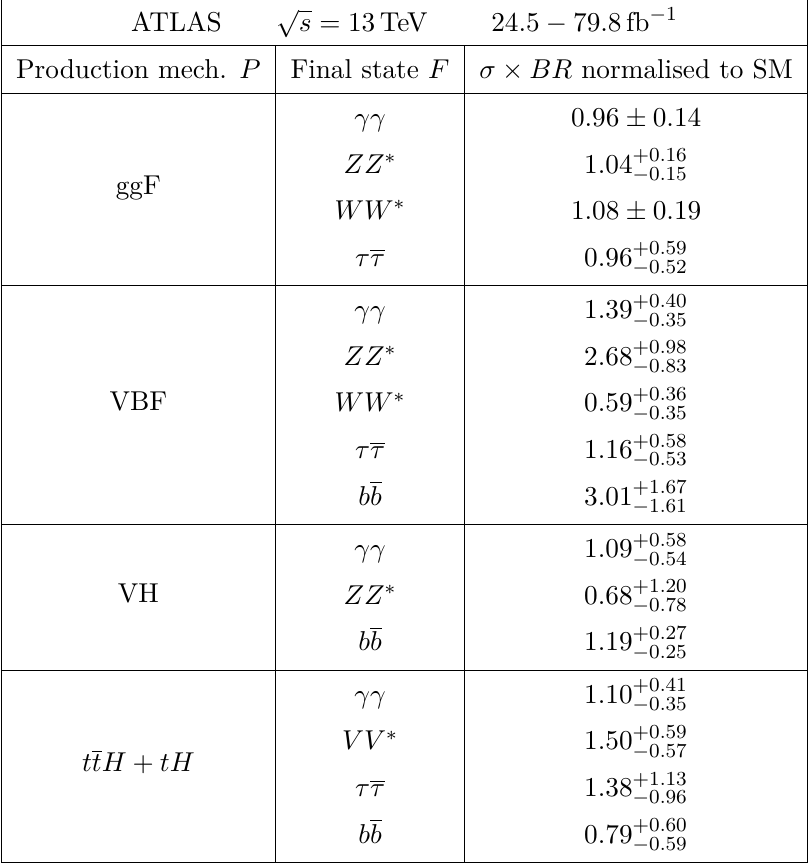
Table 2 . Higgs signal strength from ATLAS collaboration in ref. [66]. ggF stands for gluon fusion, VBF for vector boson fusion, VH for vector boson-Higgs boson associated production, ttH + tH for associated Higgs boson production with tt or single t